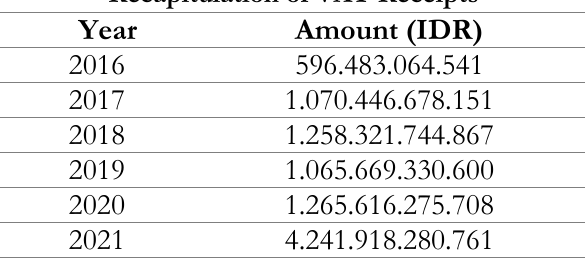
Recapitulation of VAT